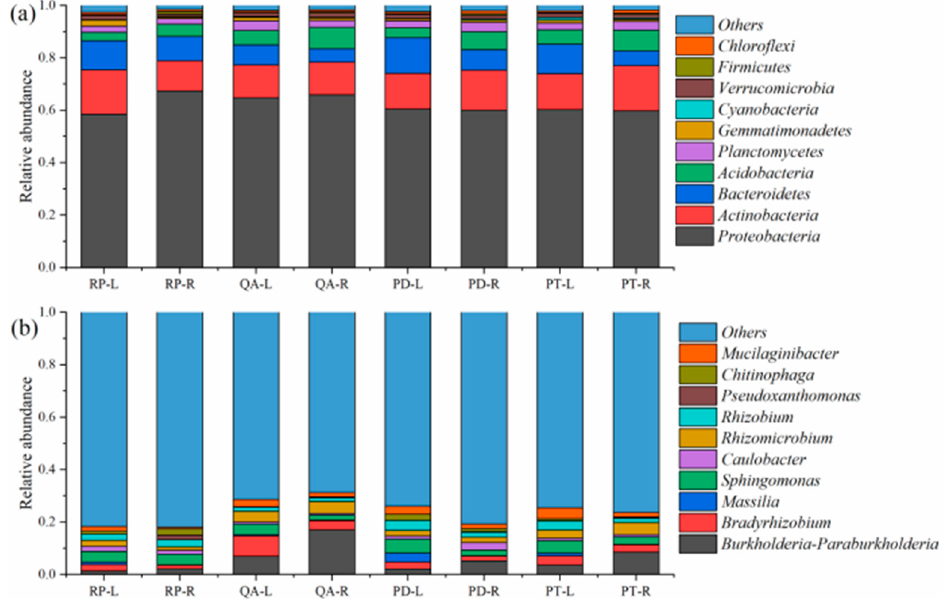
Figure 3. Relative abundance of the top ten dominant bacterial phyla ( a ) and genera ( b ). RP: R . pseudoacacia , QA: Q . acutissima , PD: P. densiflora and PT: P . tabulaeformis . L: leaf litter and R: fine